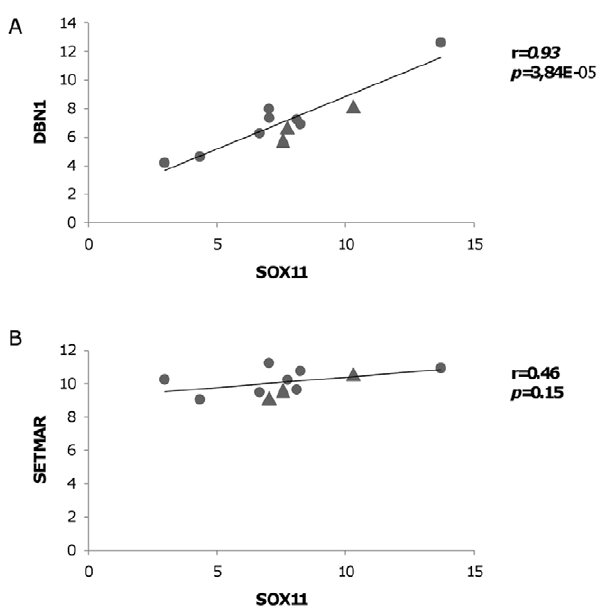
Figure 4. Expression of DBN1 correlates to SOX11 expression in primary MCL cells and MCL cell lines. The expression values of SOX11, DBN1 or SETMAR were analyzed by quantitative RT-PCR. The threshold cycle (Ct) of the gene against the Ct of b actin was determined by subtraction. All values were first tested for normal distribution, and then the Pearson correlation coefficients and P value were calculated. m MCL cell lines Granta 519, Rec1 and JeKo; MCL patients.